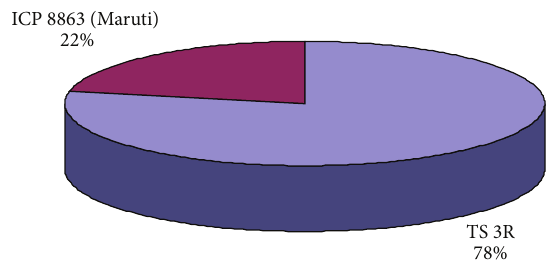
Figure 4: Varieties used for pigeonpea seed